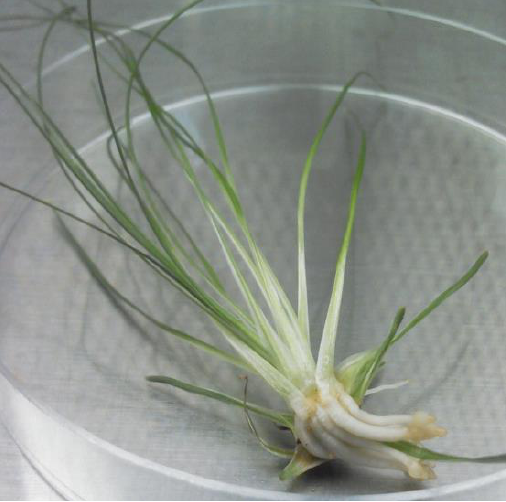
Figure 7. Xerophyllum asphodeloides after six weeks in 0.5 mg/L NAA rooting medium. Multiple vigorous roots have